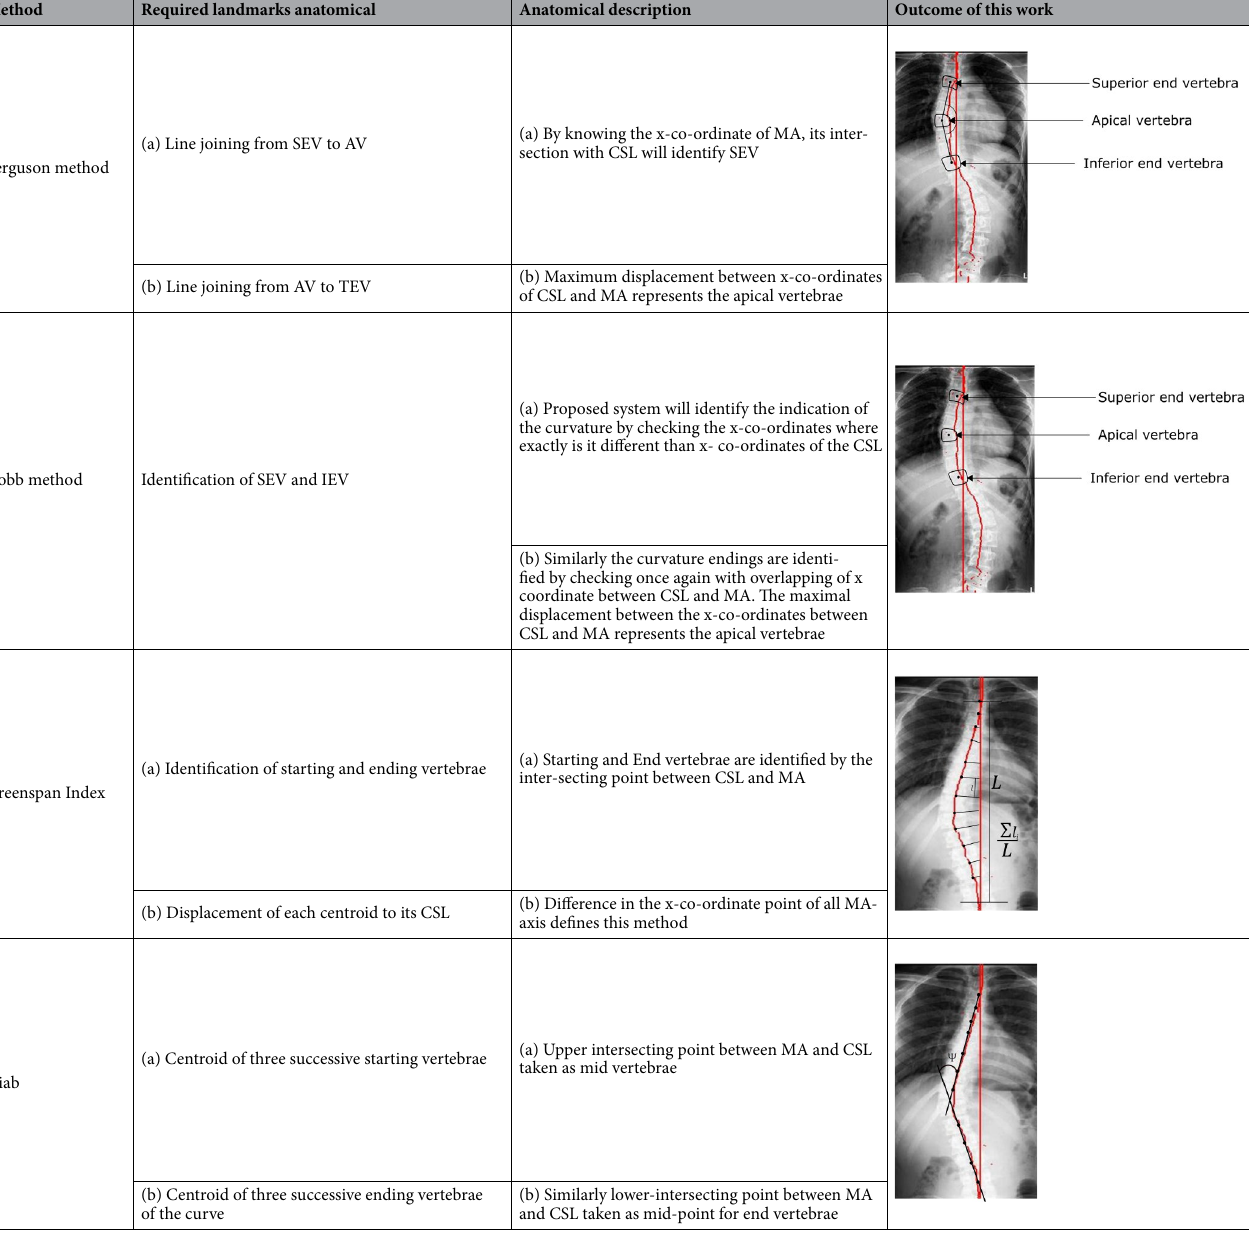
Table 1. Proposed inference in terms of anatomical description for spinal curvature